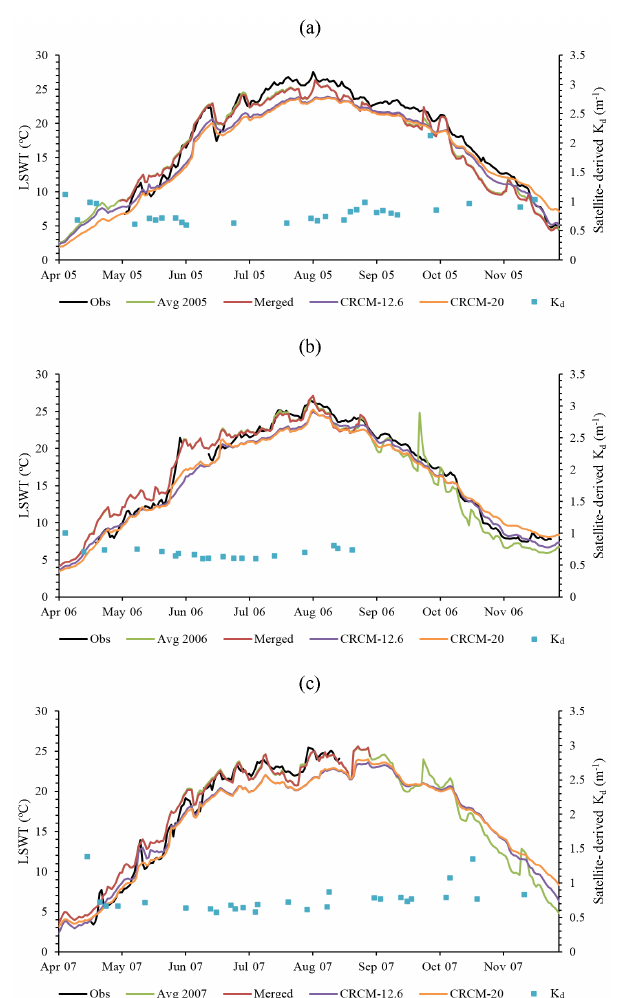
Figure 4. Daily LSWT simulation results in 2005 (a) , 2006 (b) , 2007 (c) . Avg. simulation is the CoastColour-derived average value for K d during selected months of each year (0.81, 0.71, and 0.73m − 1 , respectively). Merged simulation is based on merging simulation results for monthly average values of K d . CRCM-12.6 and CRCM-20 used a constant value of K d (0.2m − 1 ) with depth values of 12.6 and 20m, respectively. The corresponding observa- tions for LSWT are also plotted. Missing lines indicate no data.